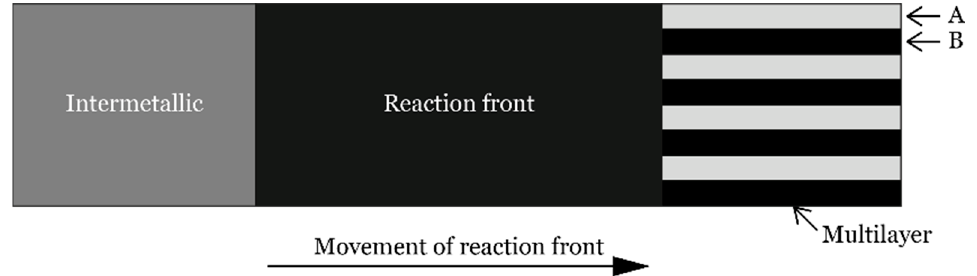
Figure 1. Schematic showing the progression of the reactive multilayer system